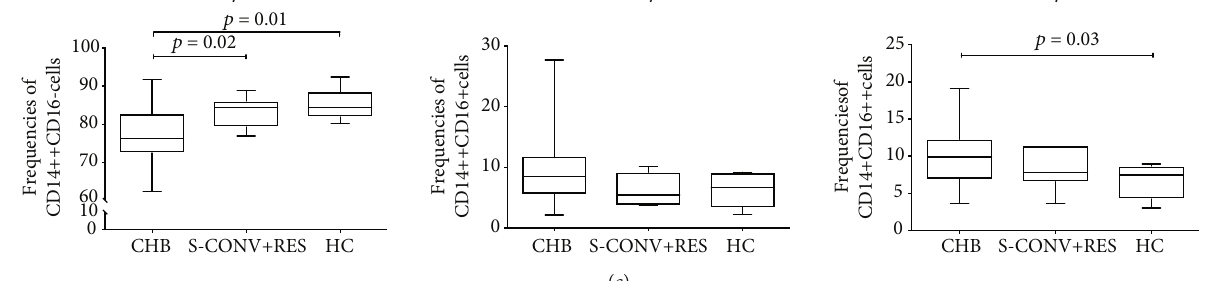
Figure 1: Peripheral monocyte frequencies in studied groups. (a) Gating strategy. (b) FMO controls for all studied groups (upper row) with representative dot plots of monocyte subsets in CHB, S-CONV+RES groups and healthy controls. Values in quadrants indicate the proportion of monocyte subset. (c) Summarised comparative analysis of monocyte subsets in CHB, S-CONV+RES patients, and healthy controls. p values are shown if signi fi cant. Horizontal bars represent median proportion of monocyte